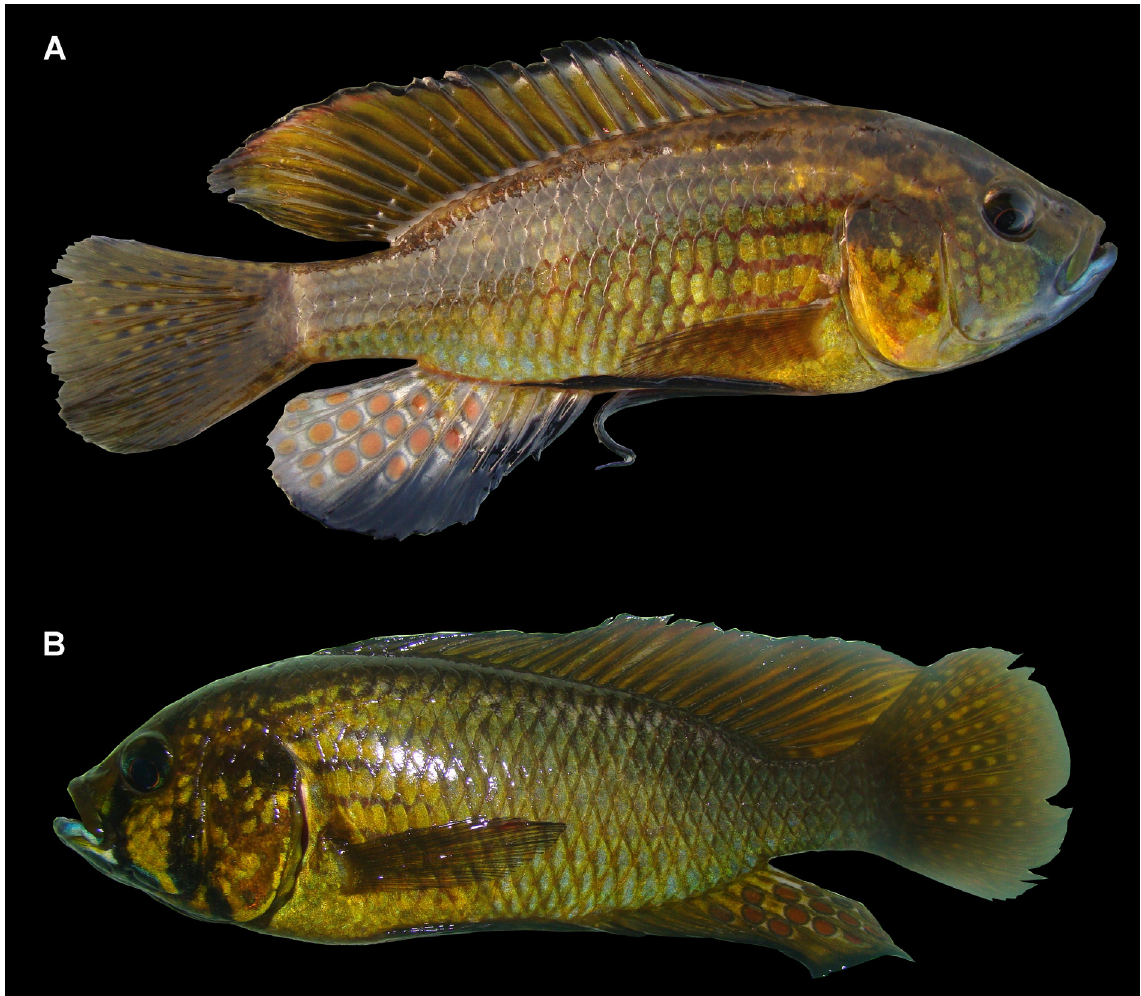
Fig. 6. Adult ♂♂ of Astatoreochromis straeleni (Poll, 1944) . A . MRAC A9-13-P-555, 70.6 mm SL, collected on 13 Dec. 2008 in the Malagarazi. B . MRAC B1-3-P-1, 88.3 mm SL, collected on 7 Jan. 2011 in the Rusizi. (Photographs by